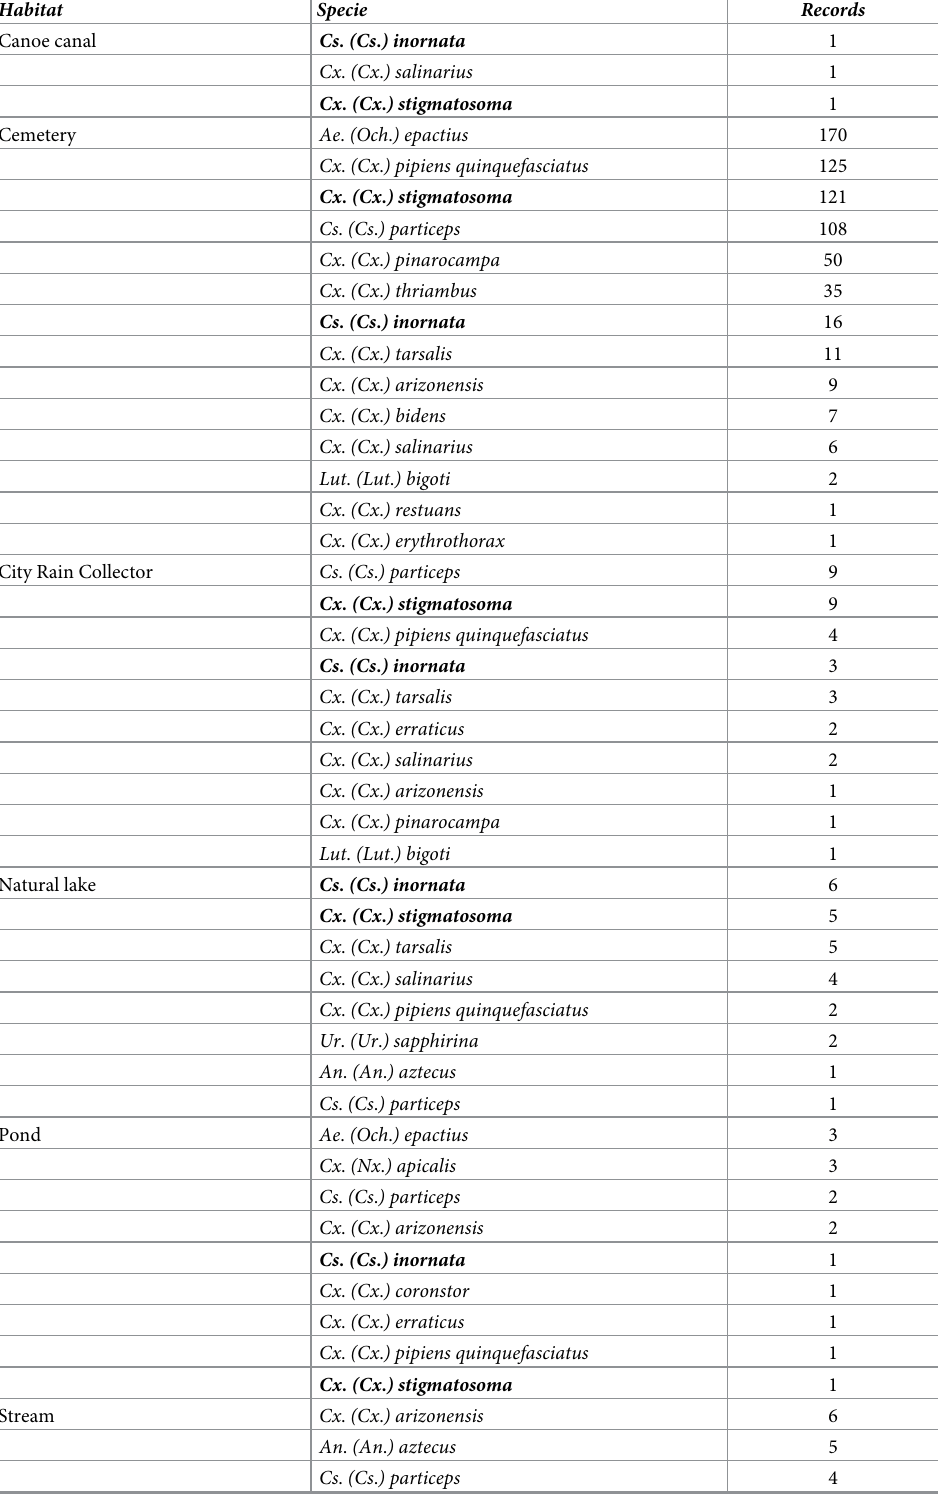
Table 3. Type of sampling habitat and number of records for each